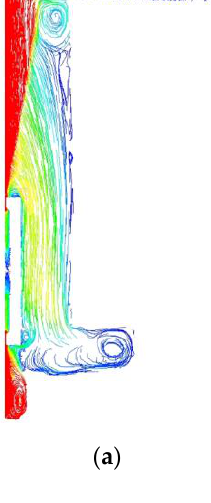
Figure 16. Streamlines, m/s (limited by the value of 20 m/s): ( a ) 1 reaction EDC; ( b ) 60 reactions EDC; ( c ) 305 reactions EDC.